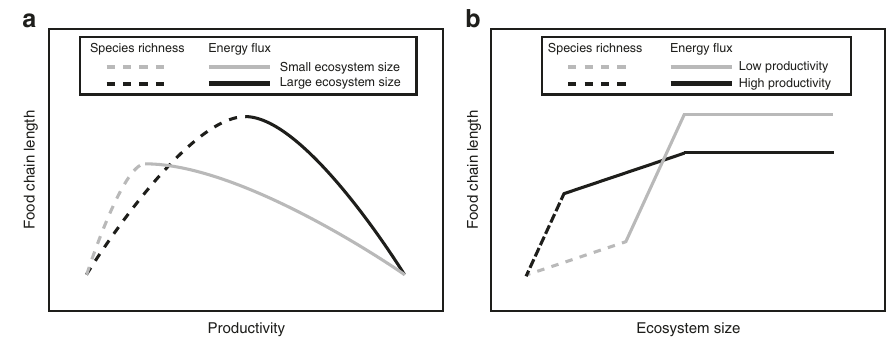
Fig. 3 Context-dependency in mechanistic drivers of food-chain length a in systems with low a PC (effectively ‘ large ’ ecosystems) and high a PC (effectively ‘ small ’ ecosystems), and b in systems with low and high productivity. Dashed lines indicate where food chain length should be set by the Classical Species Richness mechanism; solid lines indicate where food chain length should be set by the Energy